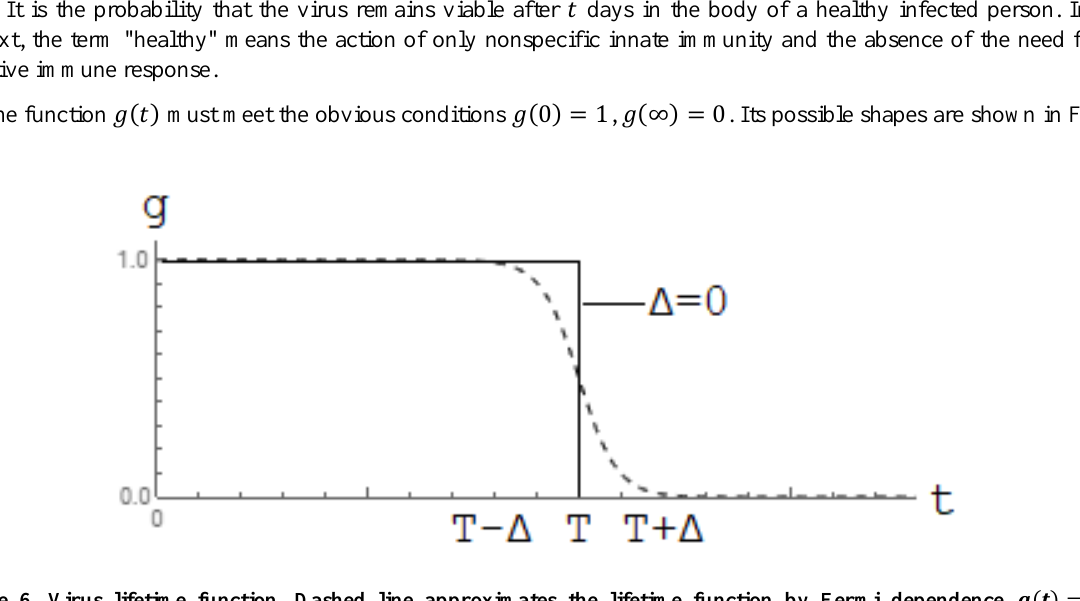
∆ = 𝟎 which is the Heaviside theta function 𝒈(𝒕) =